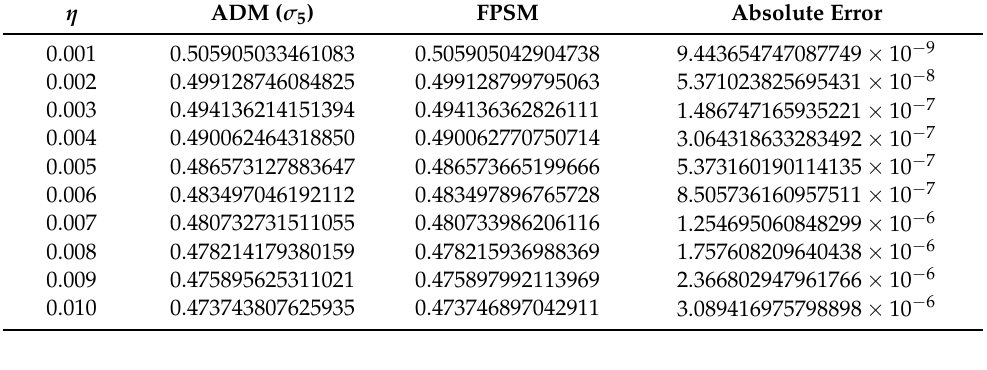
Table 3. Comparison of the numerical solutions and absolute errors for Equation (34).